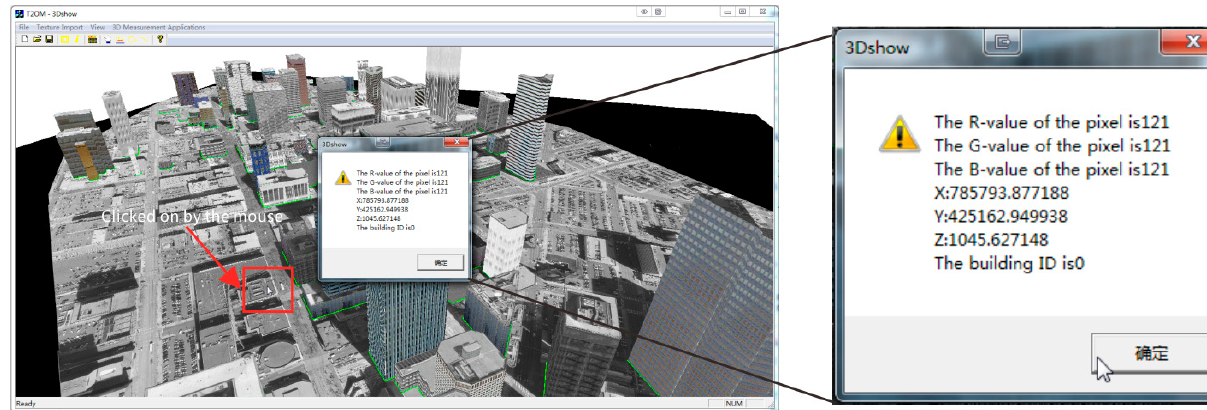
Figure 22. View of the superpixel information.